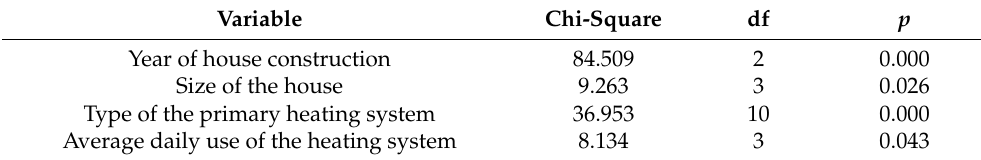
Table 1. Results of the Kruskal–Wallis test between “Heating Cost” and individual variables.